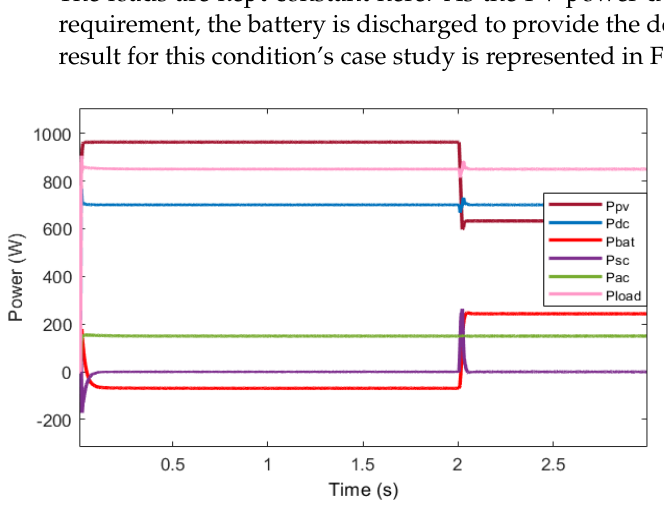
Figure 10. PV, DC load, AC load, supercapacitor, and battery power flow for sudden change in irradi- ance.